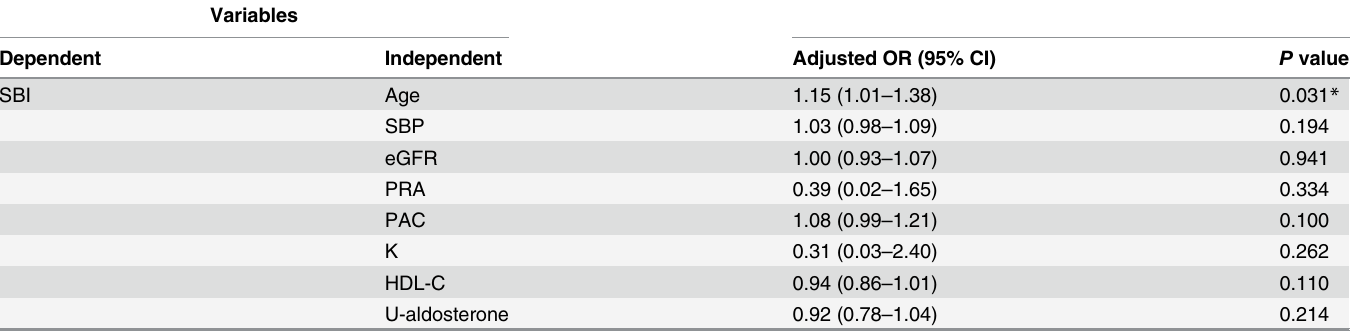
Table 2. Logistic regression analysis of independent variables affecting the presence of silent brain infarction in primary aldosteronism patients. Variables